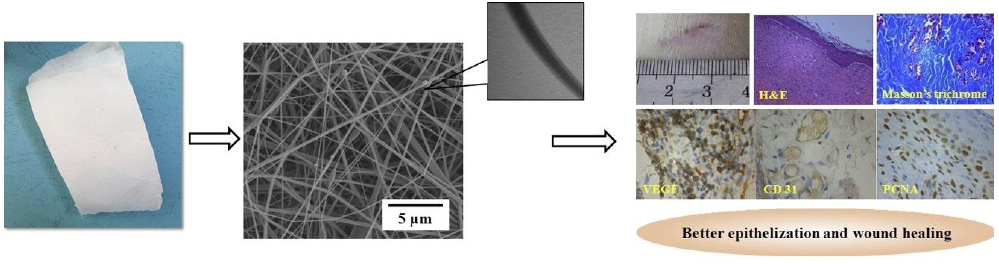
Figure 6. Illustration of asiaticoside-loaded coaxially electrospinning nanofibers containing algi- nate, polyvinyl alcohol (PVA), and chitosan in deep partial-thickness burn injury. (reprinted with permission [71] from Elsevier).